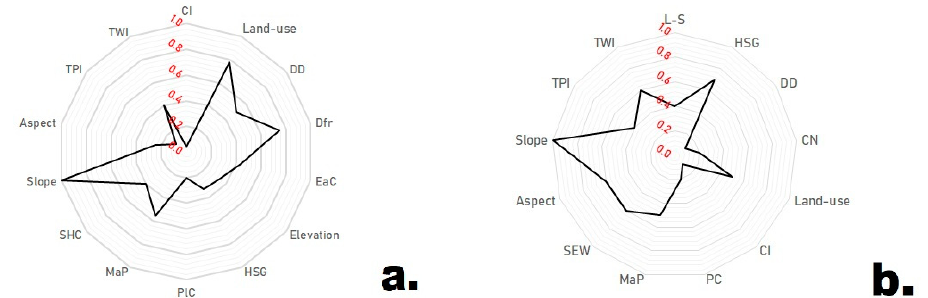
Figure 8. Variable importance for the FPI ( a ) and FFPI ( b ) in the Multilayer Perceptron Neural Network (MLP) model.